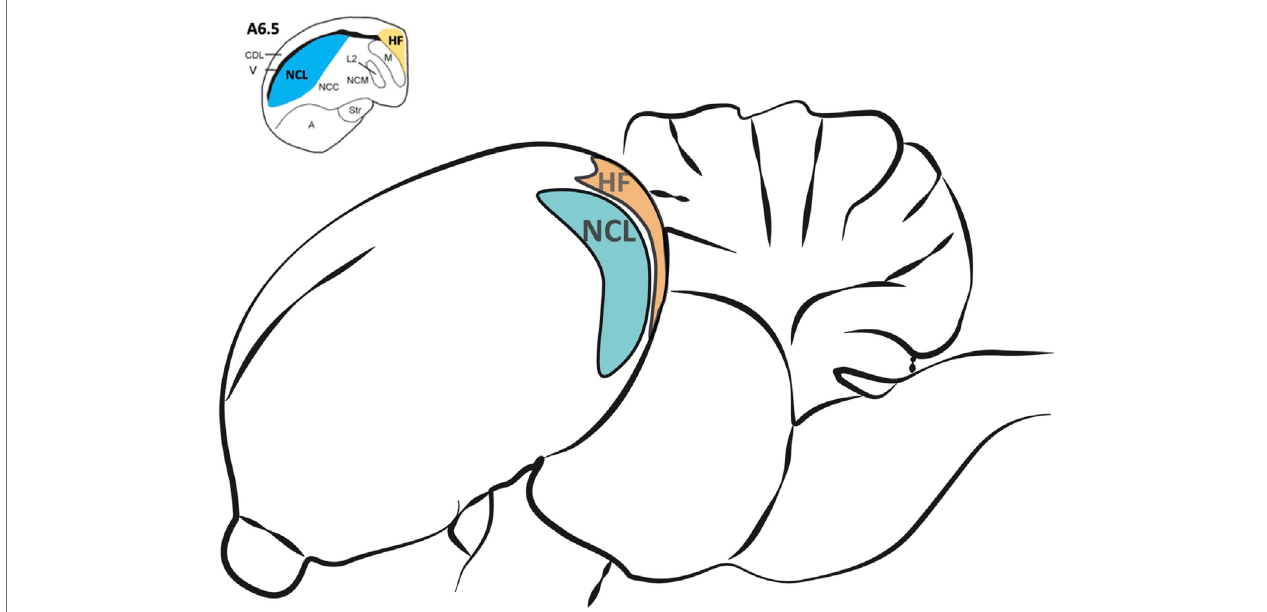
FIGURE 2 | Regions of interest for the analysis of different neurotransmitter receptor mRNA levels in the pigeon brain after learning. The nidopallium caudolaterale (NCL, blue) of pigeons is a half-moon shaped structure located laterally beneath the forebrain ventricle at the end of the caudal forebrain (see upper left). It is involved in executive functions and reward processing, comparable to the prefrontal cortex in mammals. The hippocampal formation (HF, orange) is located above the forebrain ventricle and begins at the most caudal level end of the avian telencephalon along the medial wall up to the anterior level A 9.00 (Herold et al., 2014). Here we only used HF samples caudal from A 6.50 (see upper left) because the largest portions of both, NCL and HF, are located beyond.